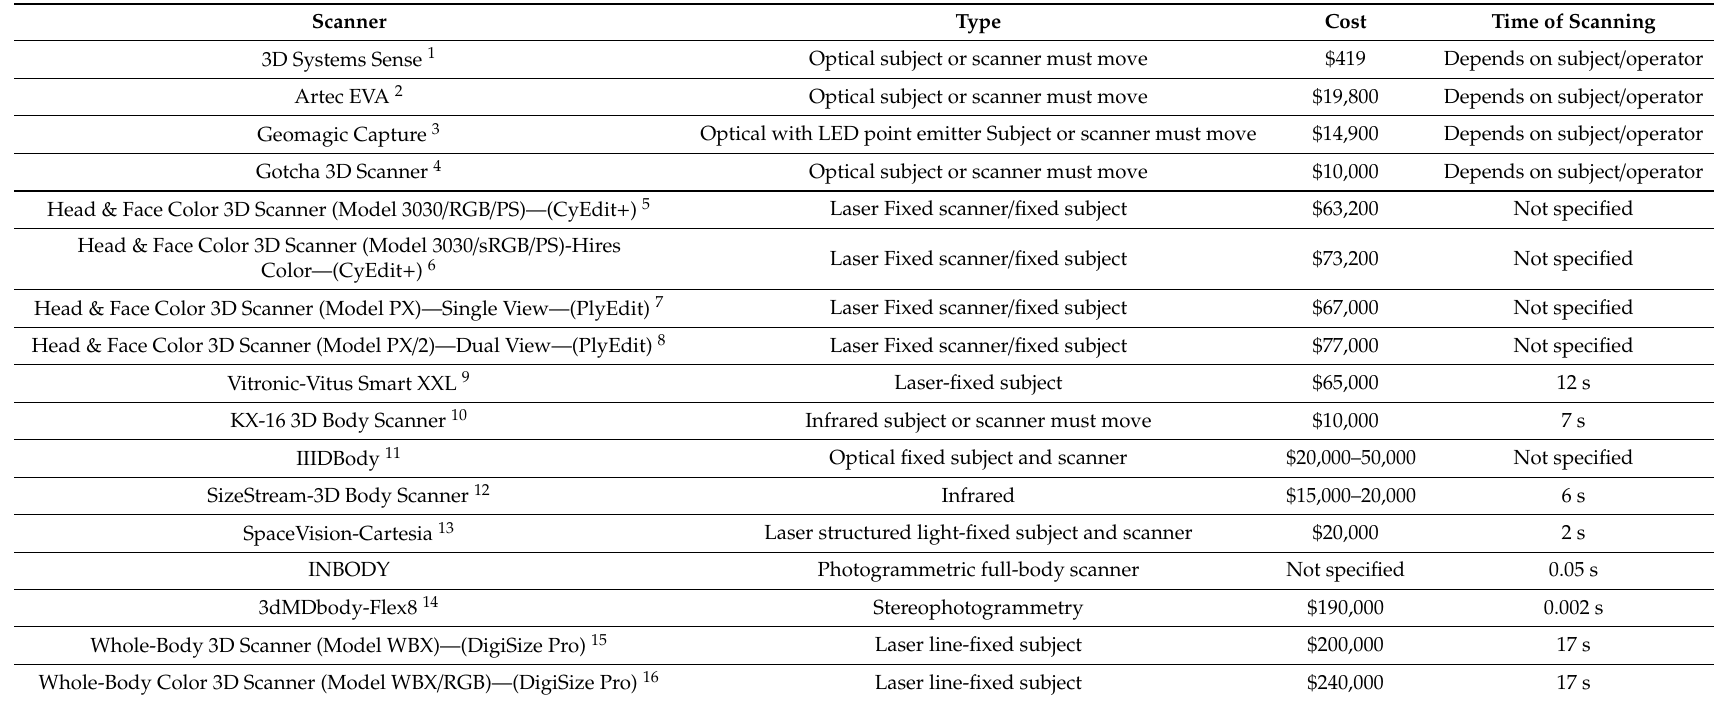
Table 1. Costs and capabilities of scanners used for human